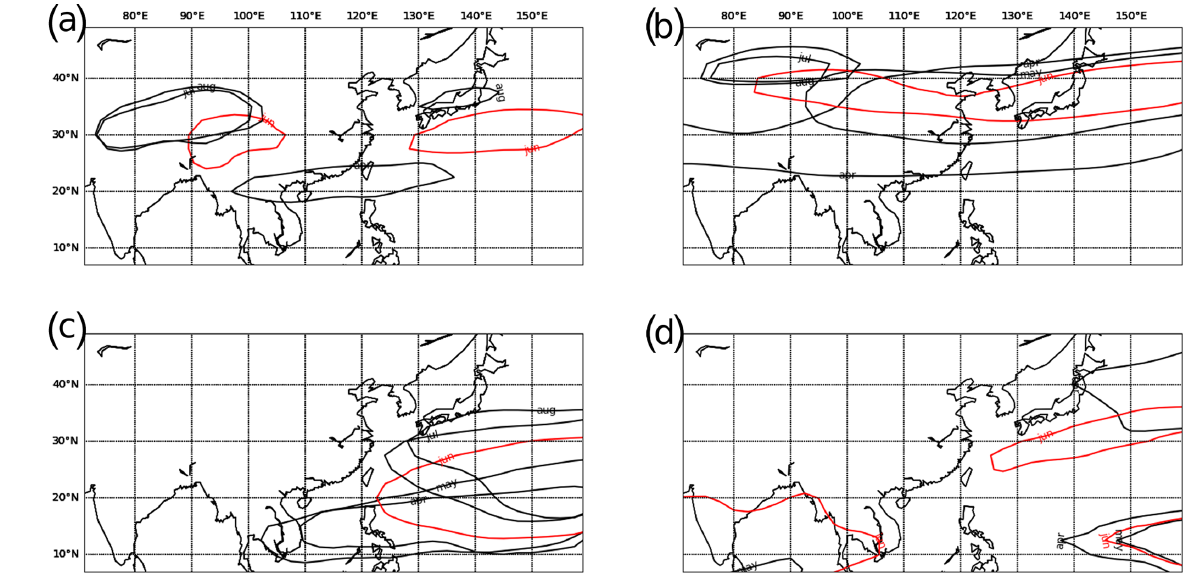
Figure 7. Monthly mean contour of (a) 200hPa relative vorticity at 2 . 8 × 10 − 5 s − 1 , (b) 200hPa isotachs of 30ms − 1 , (c) 500hPa geopotential height at 5880m, and (d) 850hPa isotachs of 7ms − 1 during April–August. Contours in June are colored